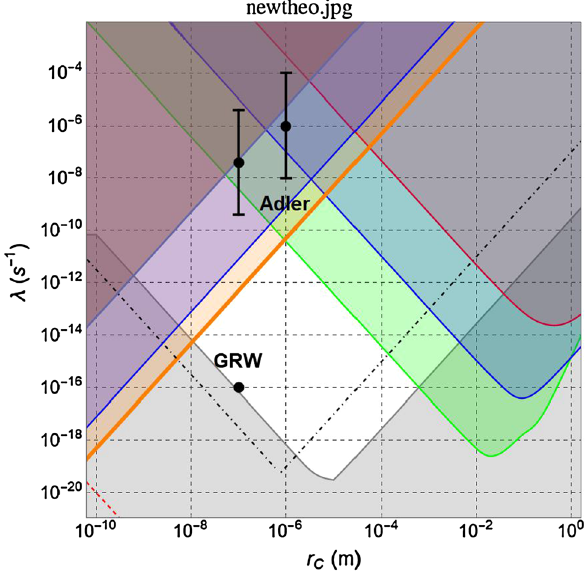
Fig. 4 Mapping of the λ − r C CSL parameters: the proposed theoret- ical values (GRW [6], Adler [24,25]) are shown as black points. The region excluded by theoretical requirements is represented in gray, and it is obtained by imposing that a graphene disk with the radius of 10 µ m (about the smallest possible size detectable by human eye) collapses in less than 0.01 s (about the time resolution of human eye) [31]. Contrary to the bounds set by experiments, the theoretical bound has a subjec- tive component, since it depends on which systems are considered as “macroscopic”. For example, it was previously suggested that the col- lapseshouldbestrongenoughtoguaranteethatacarbonspherewiththe diameter of 4000 Å should collapse in less than 0.01 s, in which case the theoretical bound is given by the dash-dotted black line [36]. A much weaker theoretical bound was proposed by Feldmann and Tumulka, by requiring the ink molecules corresponding to a digit in a printout to col- lapse in less than 0.5 s (red line in the bottom left part of the exclusion plot, the rest of the bound is not visible as it involves much smaller values of λ than those plotted here) [37]. The right part of the parameter space is excluded by the bounds coming from the study of gravitational waves detectors: Auriga (red), Ligo (Blue) and Lisa-Pathfinder (Green) [30]. On the left part of the parameter space there is the bound from the study of the expansion of a Bose–Einstein condensate (red) [28] and the most recent from the study of radiation emission from Germanium (purple) [22]. This bound is improved by a factor 13 by this analysis performed here, with a confidence level of 0.95, and it is shown in